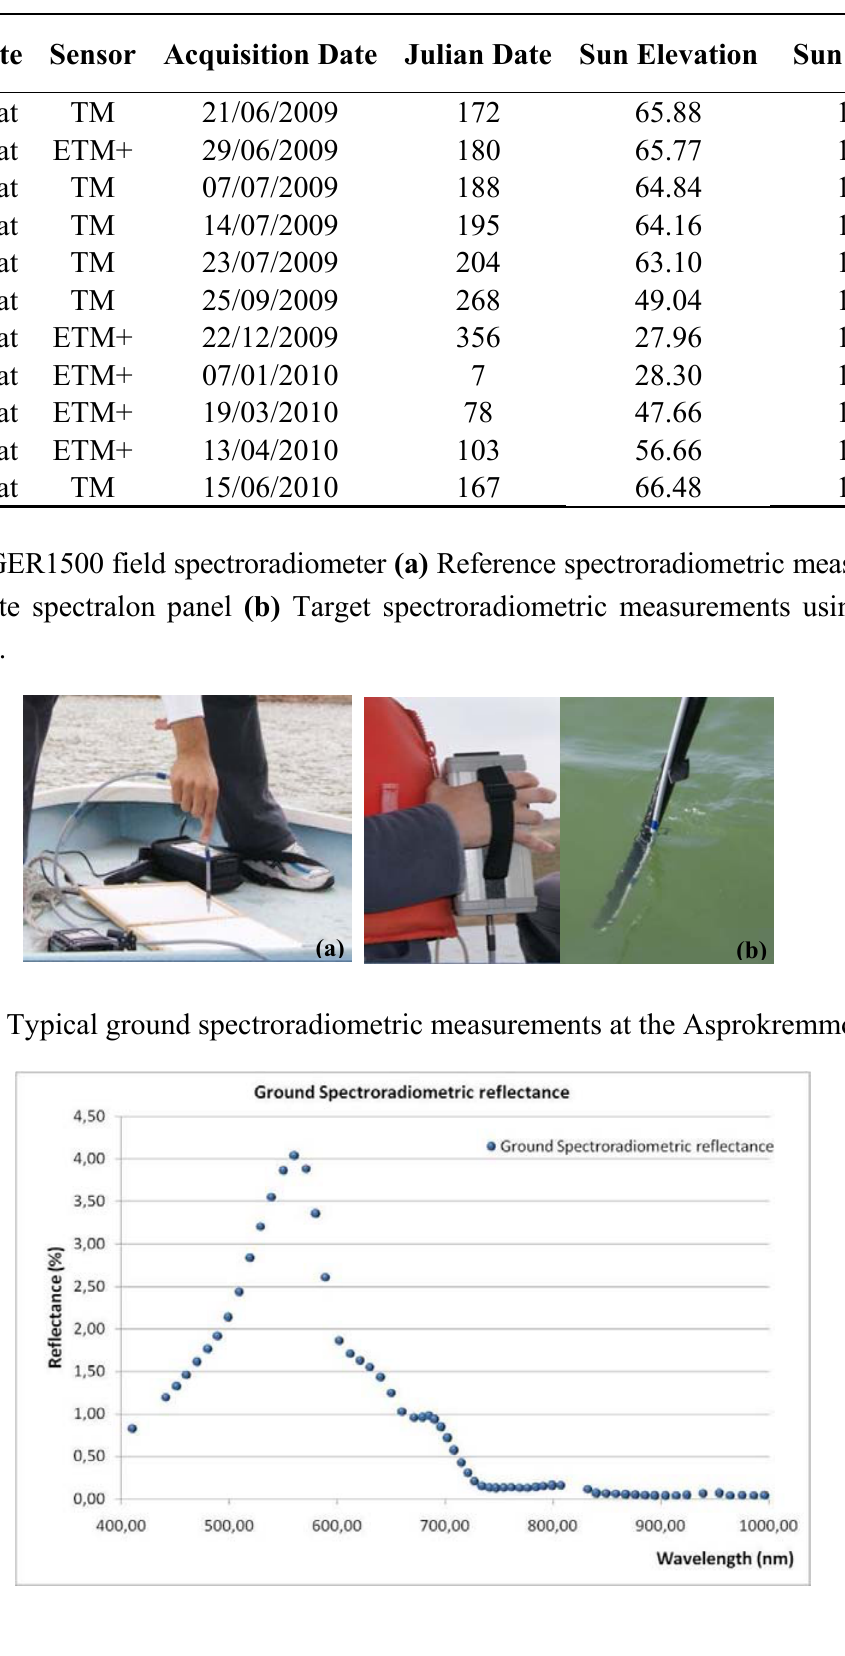
Table 1. Satellite image acquisition dates.